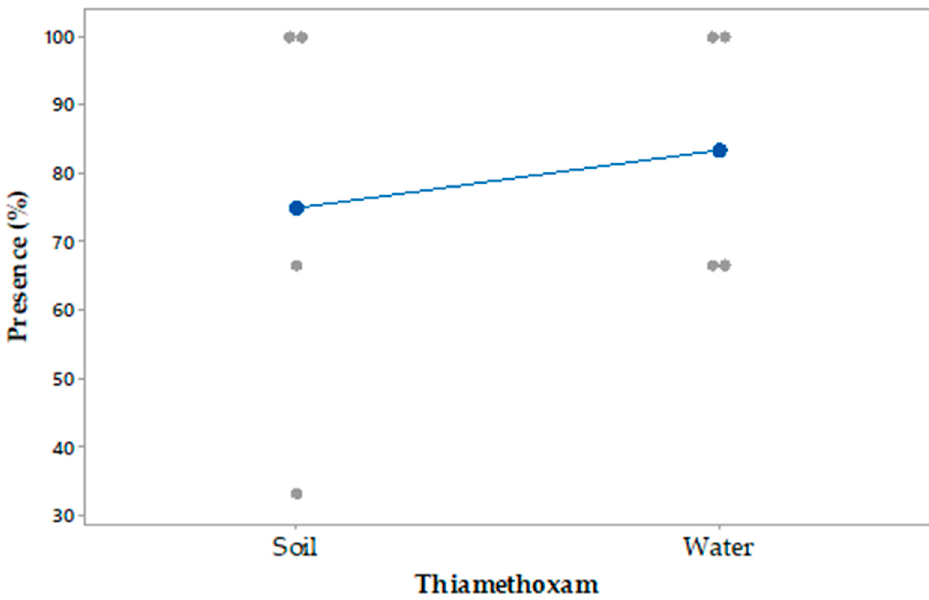
Figure 3. Presence of thiamethoxam in soil and irrigation water of the papaya crop in rotation with watermelon, where water presented significant statistical differences ( p ≤ 0.05) in the area of Cotaxtla, Veracruz.